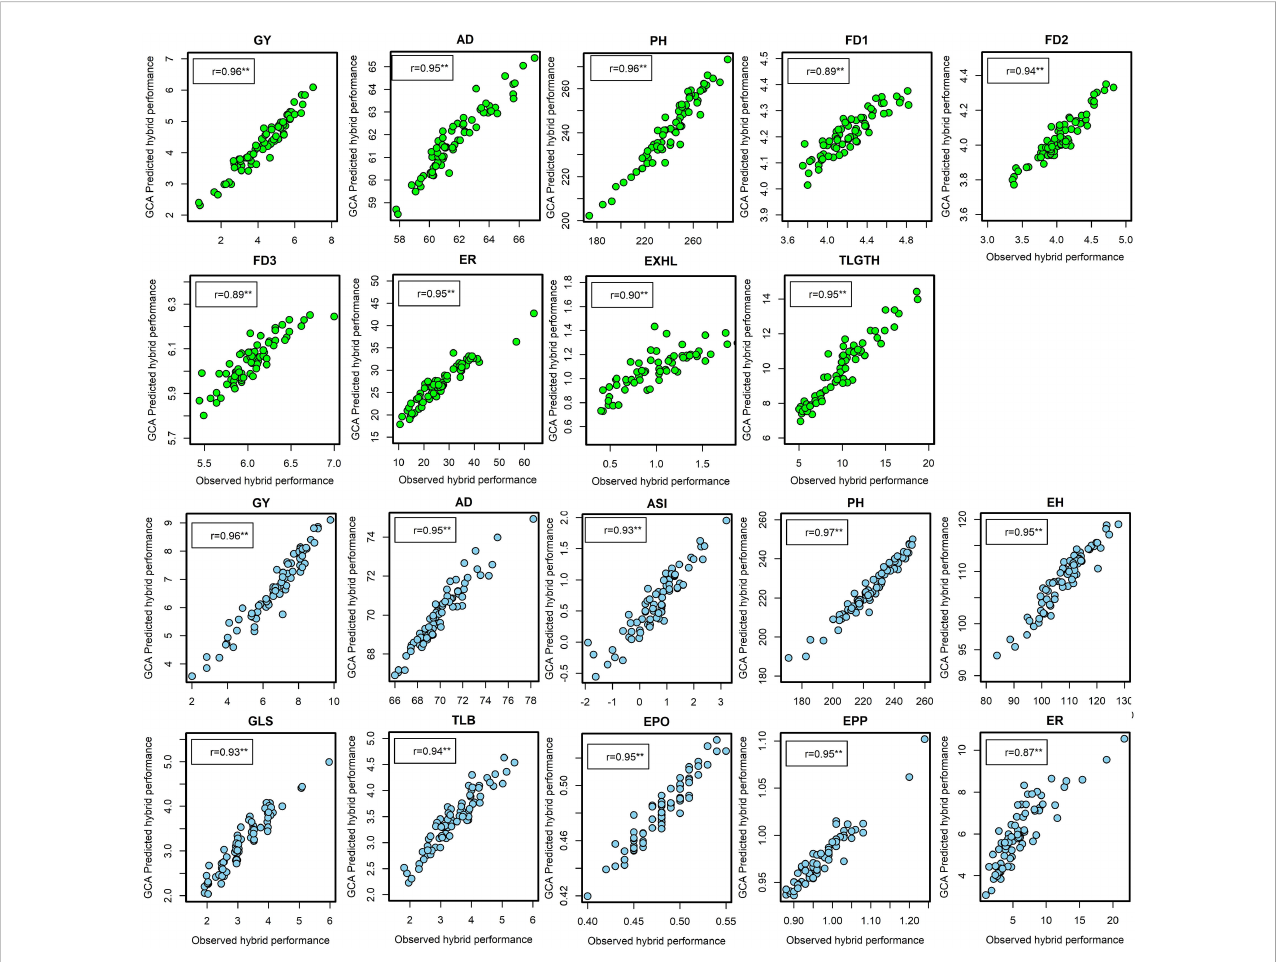
FIGURE 3 The correlation between marker-based predicted and observed F1 hybrid performance for grain yield and other agronomic traits evaluated under arti fi cial infestation (in green dots) and under optimum management (blue dots) in three to fi ve environments in experiment I. **Signi fi cant at the 0.01 probability level. ASI, anthesis to silking interval; ED, ear damage; EH, ear height; EPO, ear position; EPP, ears per plant; ER, ear rot; EXHL, number of exit holes; FD1, FD2, FD3, mean leaf damage scores 7,14 and 21 days after arti fi cial infestation respectively; GLS, grey leaf spot.; GY, grain yield; PH, plant height; t/ha, tons per hectare; TLB, turcicum leaf blight; TLGTH, tunnel